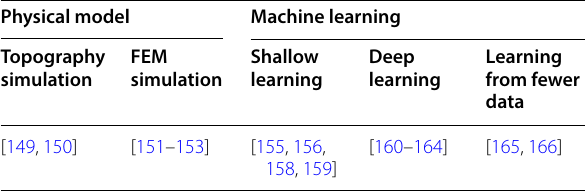
Table 8 Evolution of part condition analysis Physical